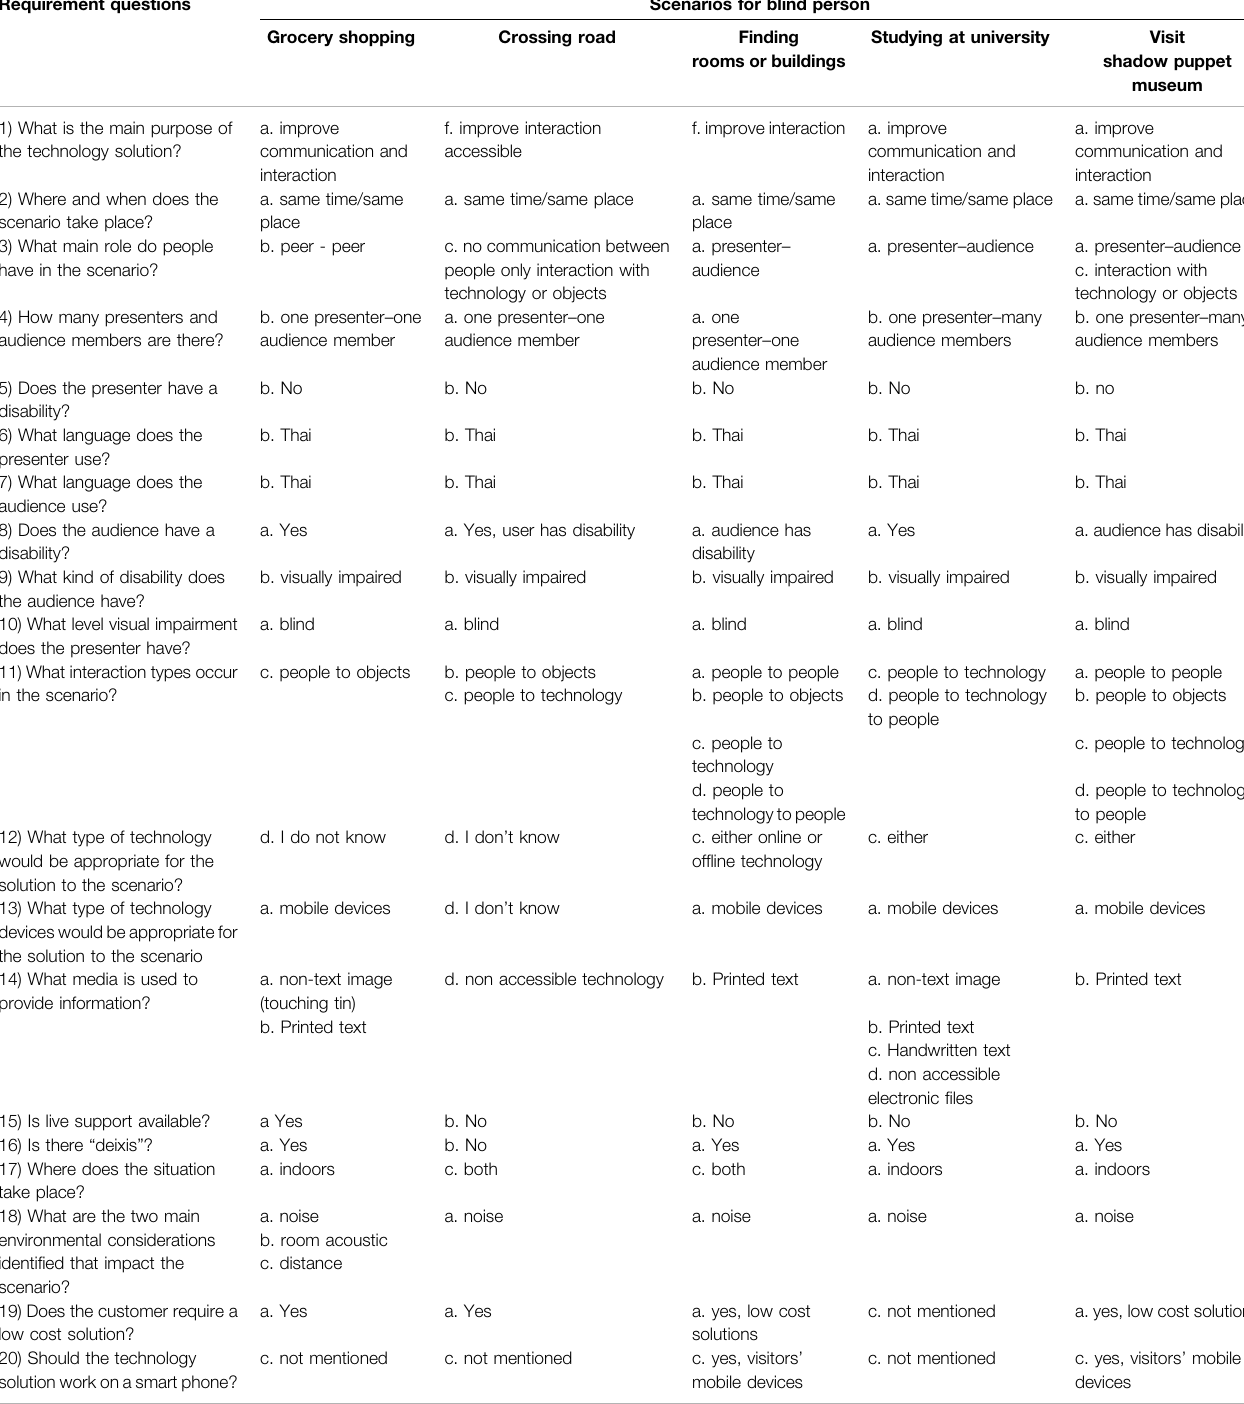
TABLE 5 | Multiple-choice requirement questions and answers for fi ve